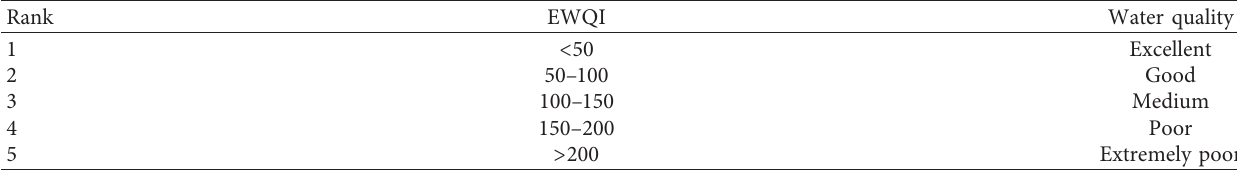
Table 1: Classification criteria of water quality based on EWQI, according to reference [25].